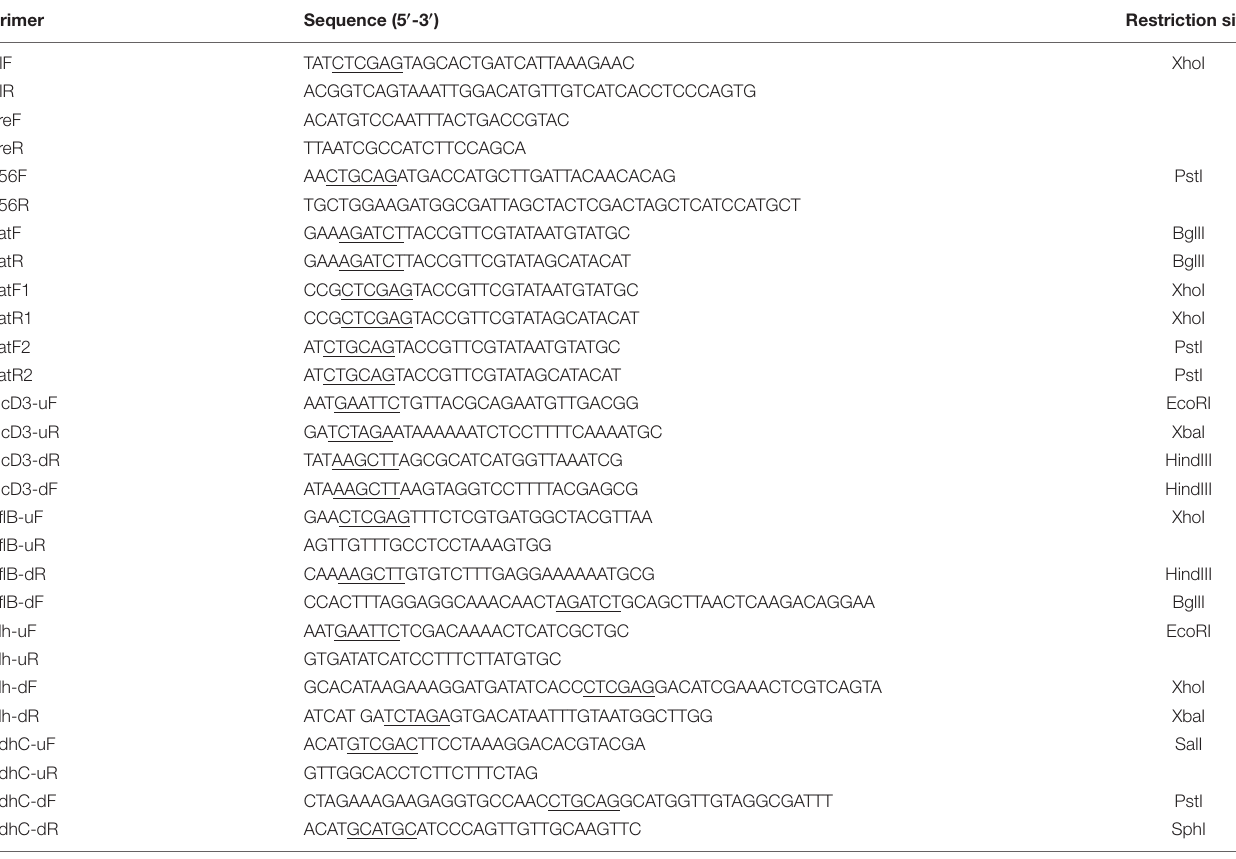
TABLE 2 | Oligonucleotide primers used in this study. Primer Sequence (5 (cid:48) -3 (cid:48) )